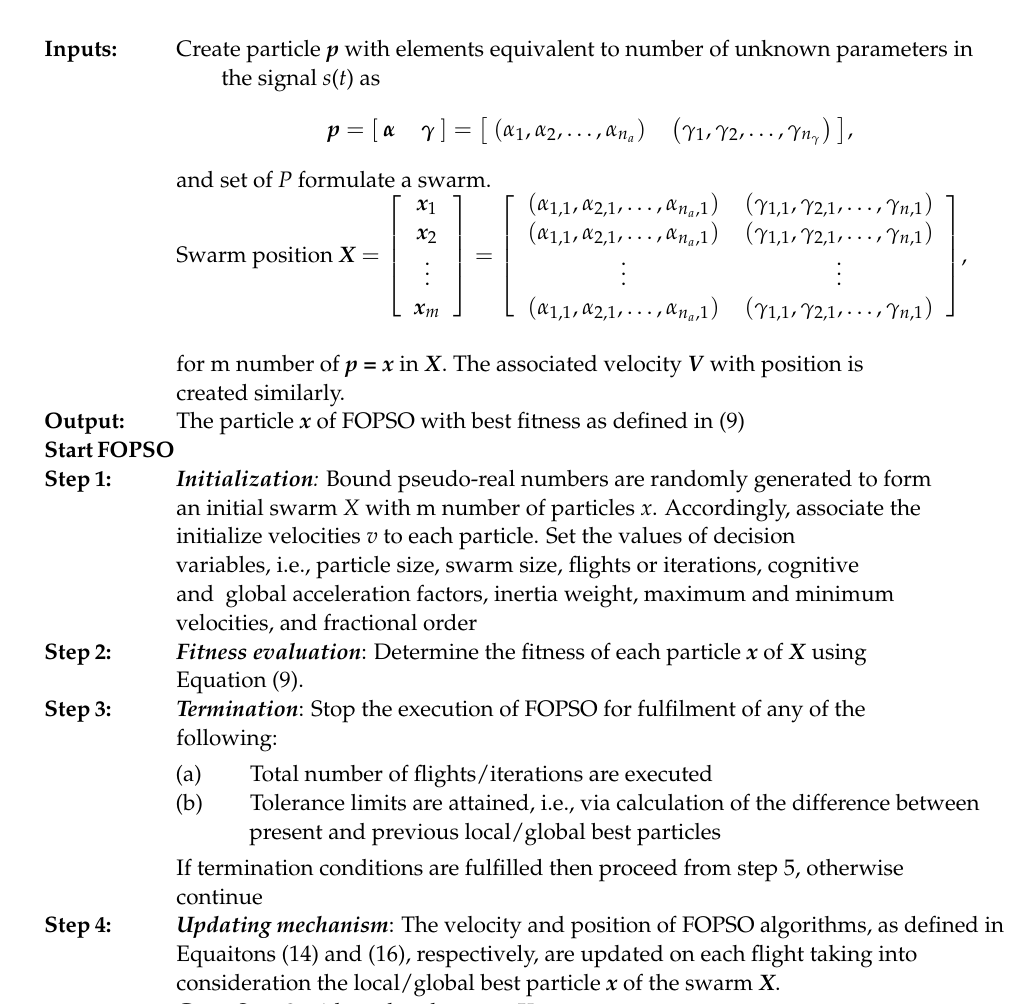
Algorithm 1. Pseudocode for FOPSO to solve the harmonics identification